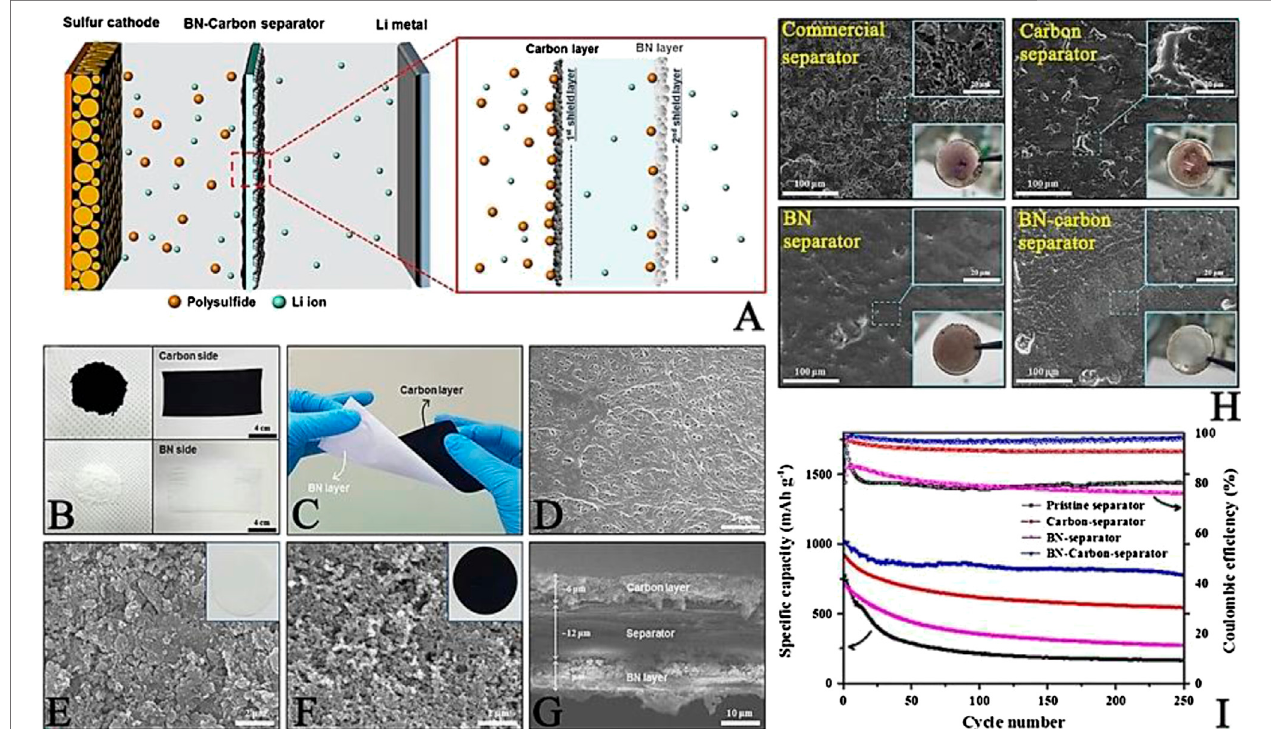
FIGURE7|(A) Schematicillustration ofthesystemicroleofaBN-carbon separatorinthedischargingprocess (B) photographsofBN-coatedseparator (C) image of a twisted BN-coated separator. SEM images of (D) pristine separator (E) the BN side and (F) the carbon side of a BN-coated separator (G) Cross-sectional view of a BN-coatedseparator (H) Photographs and morphologies oflithiummetalanodeafter 250cyclesusingdifferentseparators (I) Cycleperformancesofvarious separators at 0.5 C. Reproduced with permission from (Kim et al., 2017).